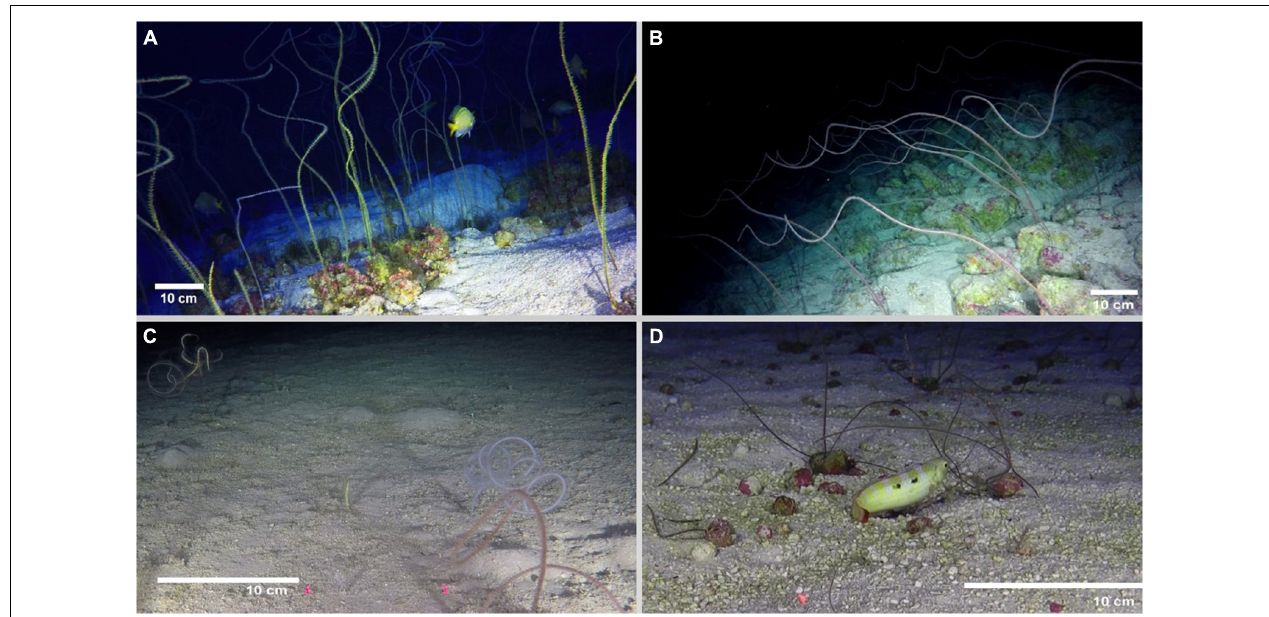
FIGURE 2 | Photographs of whip coral morphotypes of the Easter Island Ecoregion: (A) yellow morphotype ( Stichopathes sp. SCBUCN 8849), (B) red morphotype ( Stichopathes sp. SCBUCN 8850), (C) white/orange morphotype, (D) Pukao morphotype (red-small). Scale bars = 10 cm. Image credit: Matthias Gorny (OCEANA) and ESMOI.